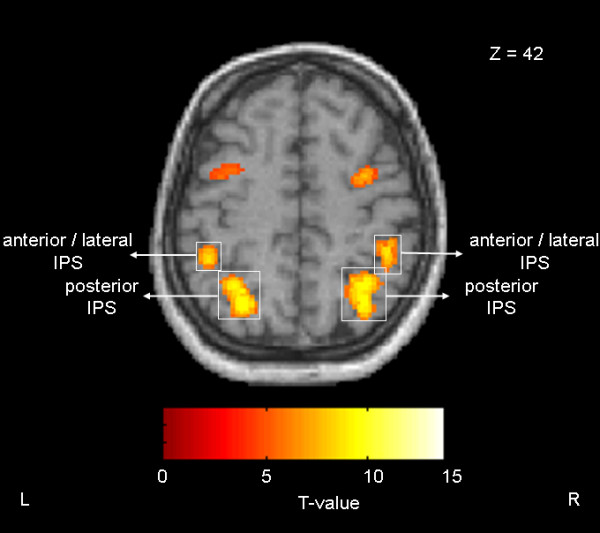
Activation pattern of a representative subject as a result of the comparison of the double-cue condition relative to baseline. The areas were significantly activated at P < 0.05 corrected. The figure depicts differential activation between the anterior/lateral and the posterior IPS. IPS = intraparietal sulcus, L = left hemisphere, R = right hemisphere.